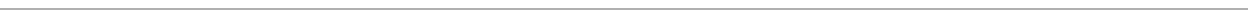
colocalization was determined by confocal analysis. Cells were stained with Drp1 antibody (green), mitotracker (red) and DAPI (blue). Lower panels show enlarged areas of the white boxes in the above panels (Scale bar: up: 8 μ m, down: 2.5 μ m). (I) Pearson ’ s coef fi cient per cell of (Drp1/mitochondria colocalization) was determined using Image-pro Plus software and is provided as a histogram. One-way ANOVA followed by Tukey post hoc comparisons tests were performed in all statistical analyses. # p < 0.05, ## p < 0.01 and ### p < 0.001 vs. Control group, * p < 0.05, ** p < 0.01 and *** p < 0.001 vs. Drp1 overexpression